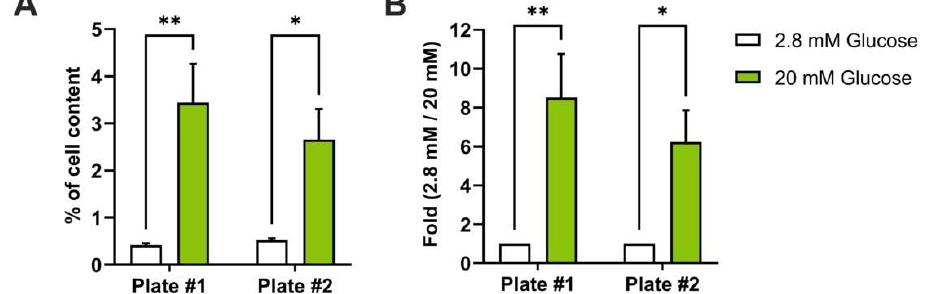
Figure 1. Automated GSIS is efficient to measure insulin secretion of Min6 cells. Min6 cells were cultured in 384-well plates and subjected to automated GSIS. ( A , B ) Insulin concentration was mea- sured using ELISA and GSIS results were expressed as percentage of insulin content (( A ), n = 5) or fold induction over 2.8 mM glucose (( B ), n = 5). Statistical analyses were performed using two-way ANOVA with Bonferroni post-test analyses. Results are presented as means ± SEM. * p < 0.05; ** p < 0.01.